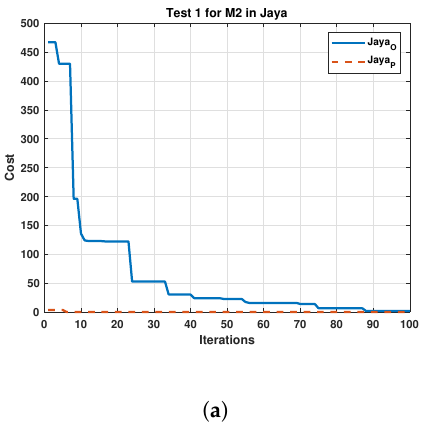
Figure 8. Comparison between the Original and the Proposed Jaya in four test for Motor 1. ( a ) cost and iterations of the Jaya in test 1 for Motor 1; ( b ) cost and iterations of the Jaya in test 2 for Motor 1; ( c ) cost and iterations of the Jaya in test 3 for Motor 1; ( d ) cost and iterations of the Jaya in test 4 for Motor 1.